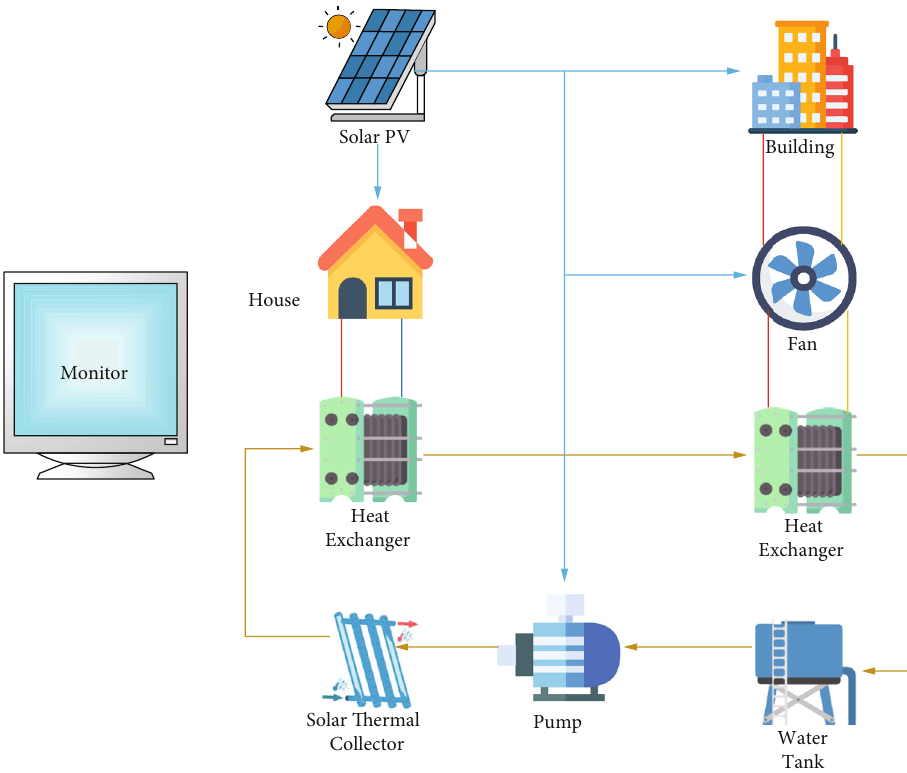
Figure 5: Water and space heating